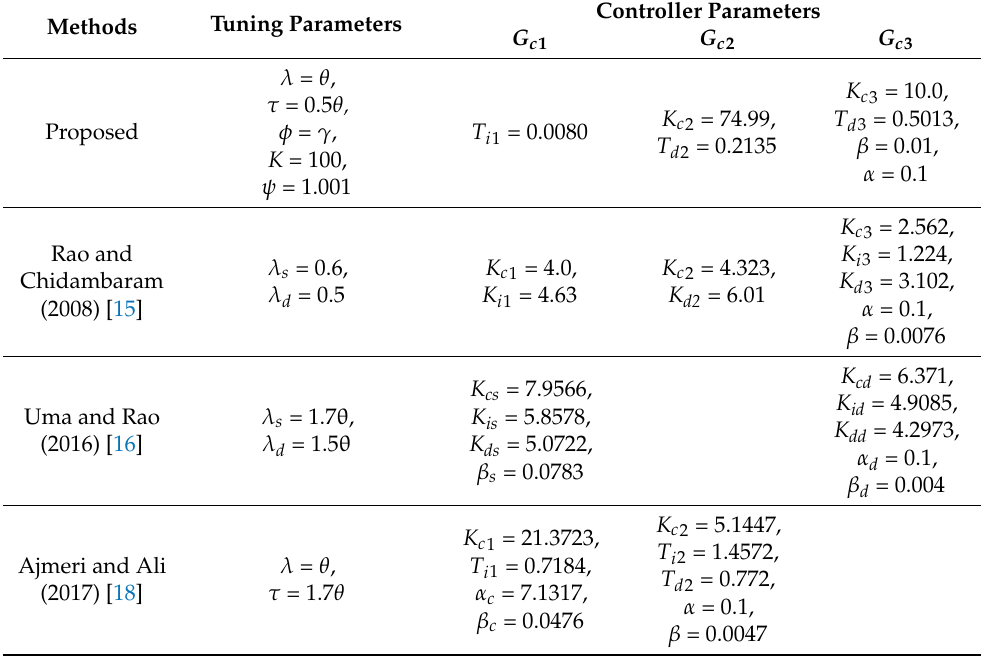
Table 6. Controller parameters for Example